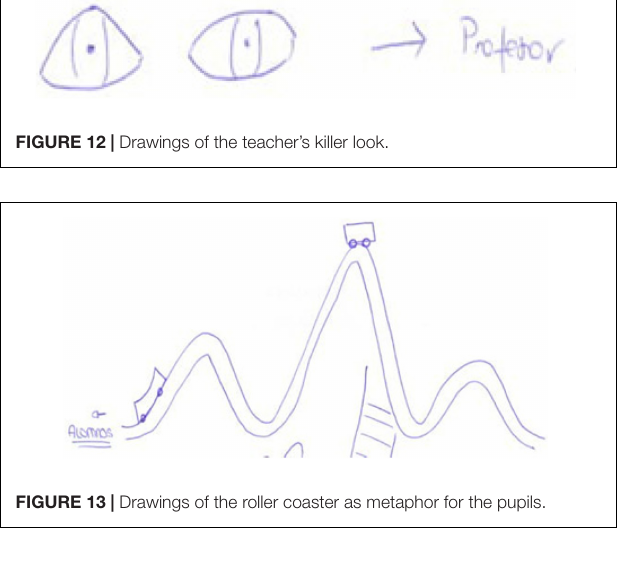
FIGURE 9 | Drawing of the teacher as an engine driver.